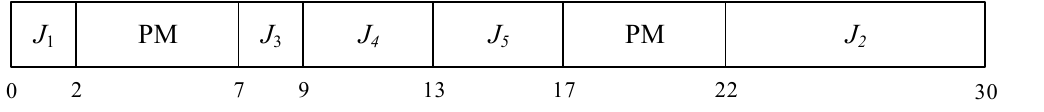
Figure 2. Gantt chart obtained by FF method.